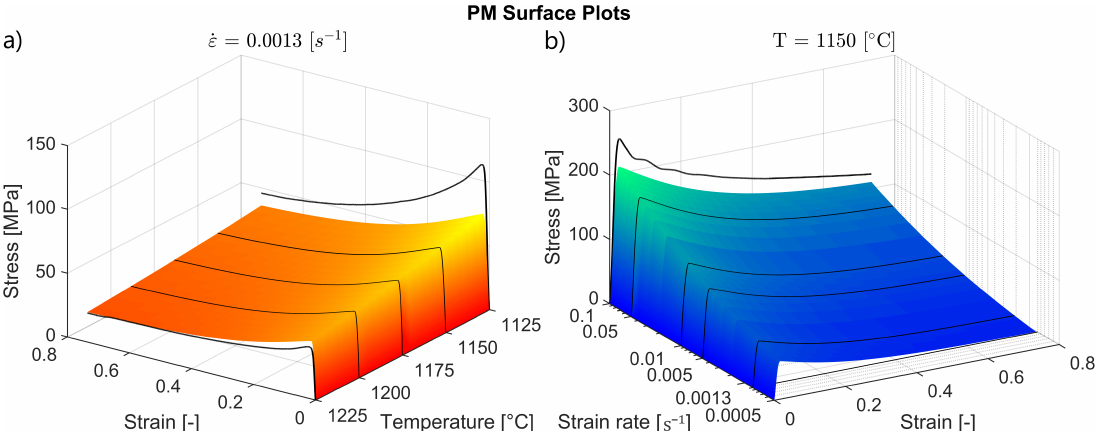
Figure 12. Surface plots of stress values predicted by the PM for interpolated and extrapolated inputs; ( a ) temperatures between 1125 and 1225 ◦ C with an increment of 5 ◦ C; ( b ) strain rates between 0.0005 and 0.1 s –1 with 10 increments between each